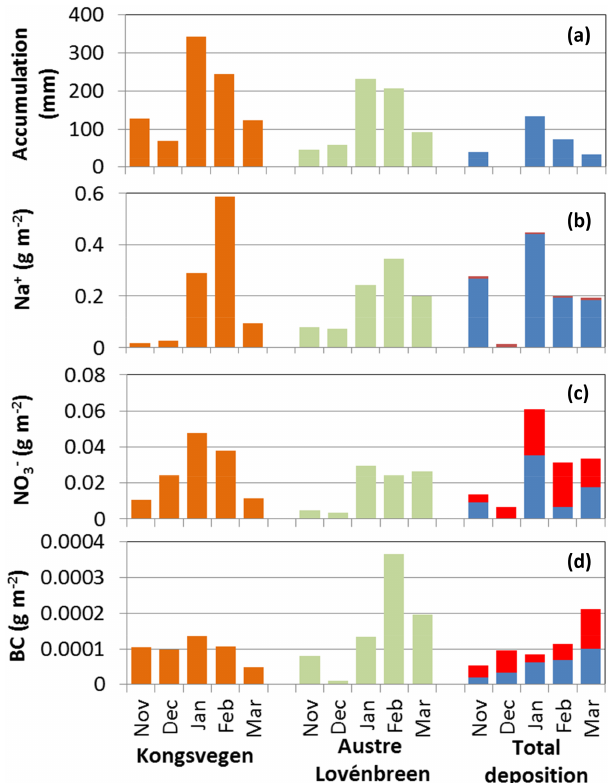
Figure 5. Monthly accumulation and snow budgets for sodium, nitrate, and BC for the snow pits KV (Kongsvegen, orange) and AL (Austre Lovénbreen, green) according to the simulated profiles. Also shown is the observed accumulation at Ny-Ålesund (top, blue) and the total deposition divided into wet (blue) and dry (red) de- position. For sodium and nitrate the wet deposition was measured at Ny-Ålesund and the wet deposition for BC was estimated from scavenging. The BC snow budgets correspond to rBC, while the wet and dry depositions correspond to